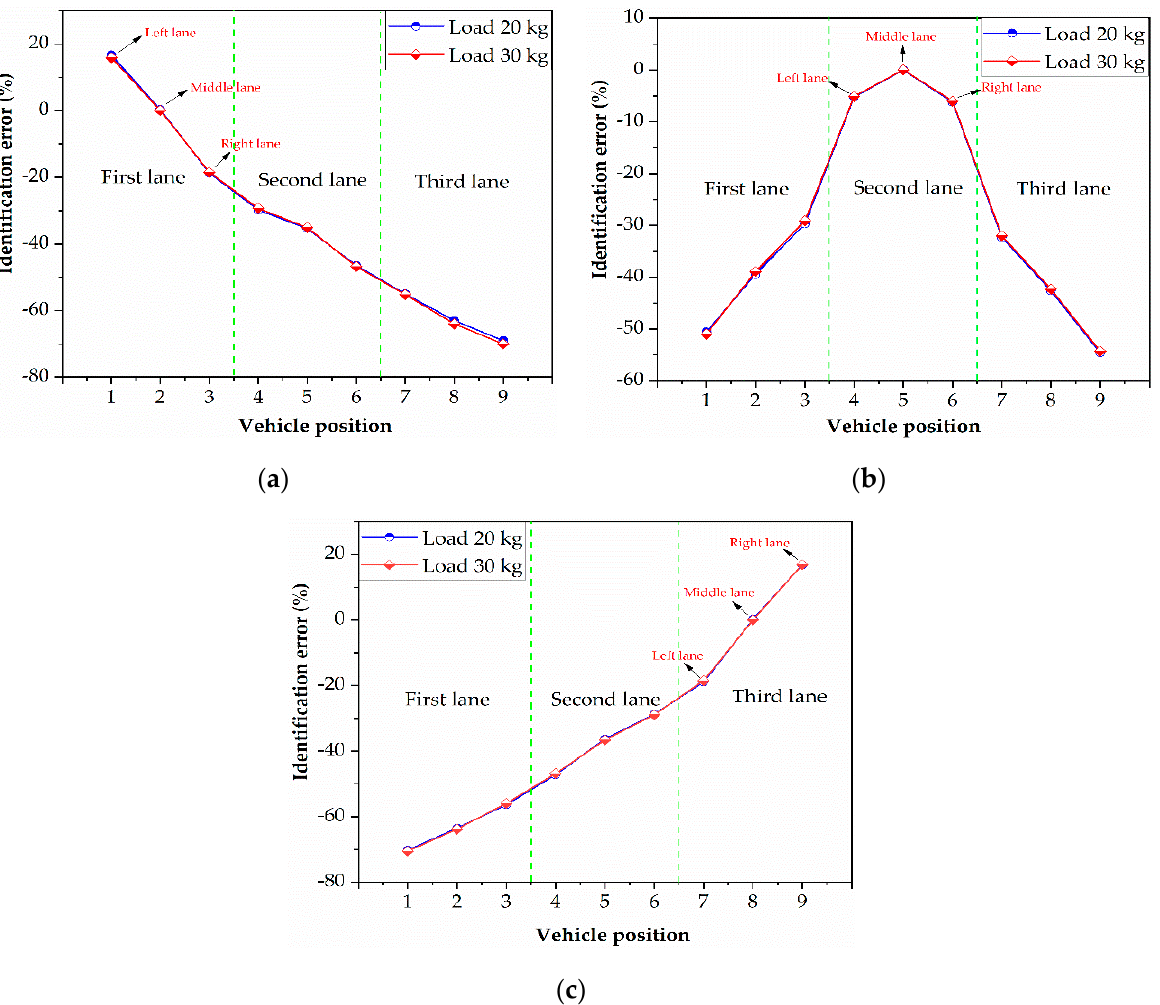
Figure 8. Identification results according to the strain integral coefficient of ( a ) 1# beam, ( b ) 3# beam, ( c ) 5# beam.